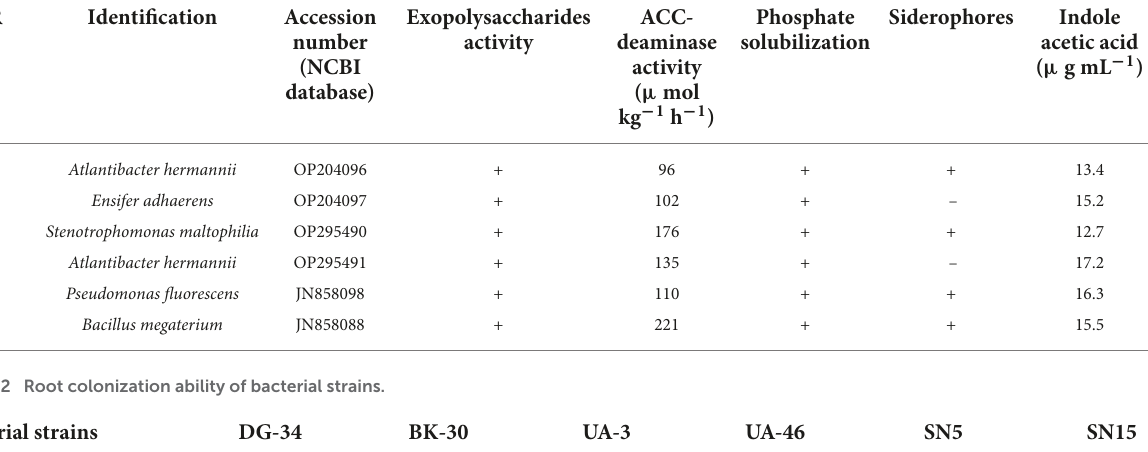
TABLE 1 Characterization and identification of the rhizobacterial strains.